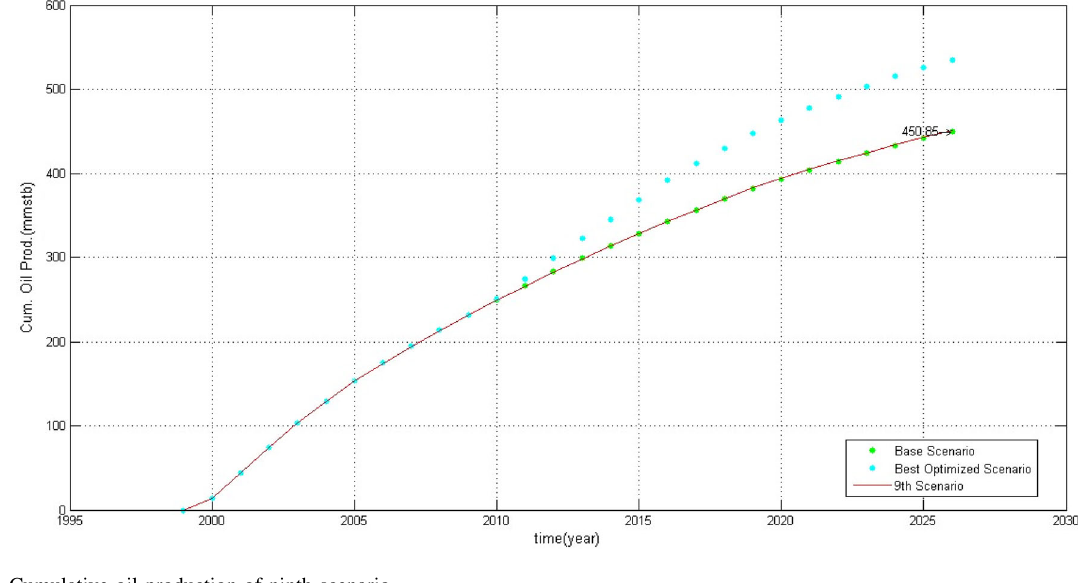
Fig. 18 Cumulative oil production of ninth scenario